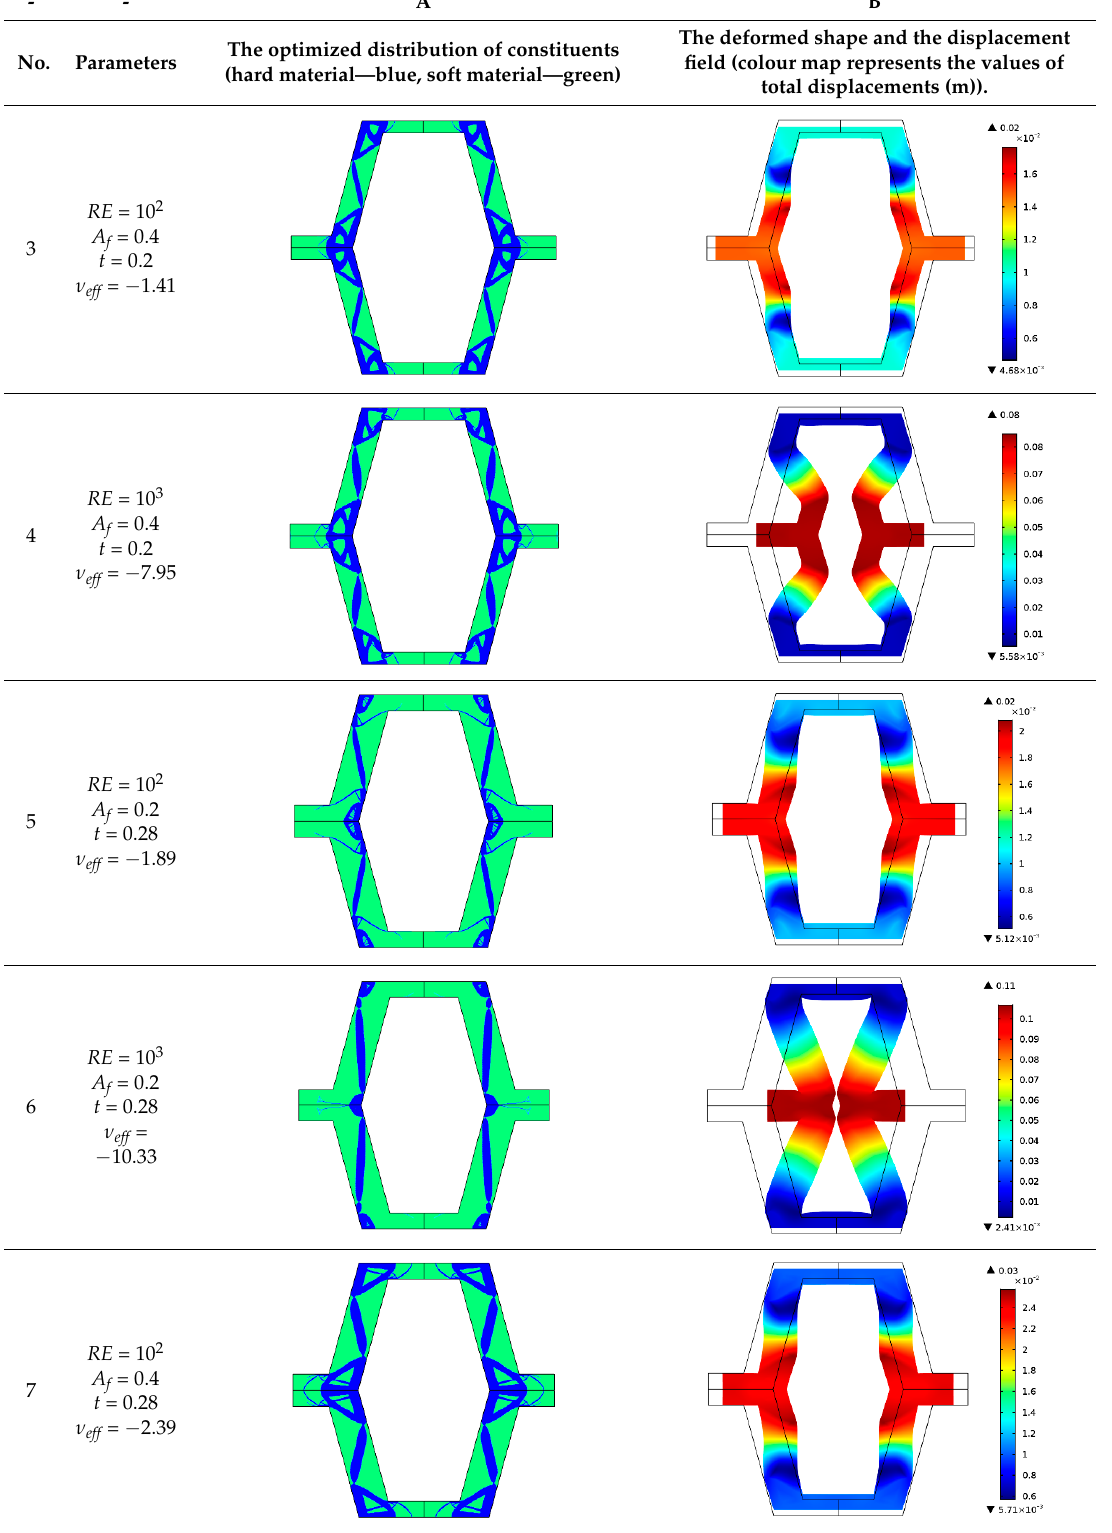
total displacements